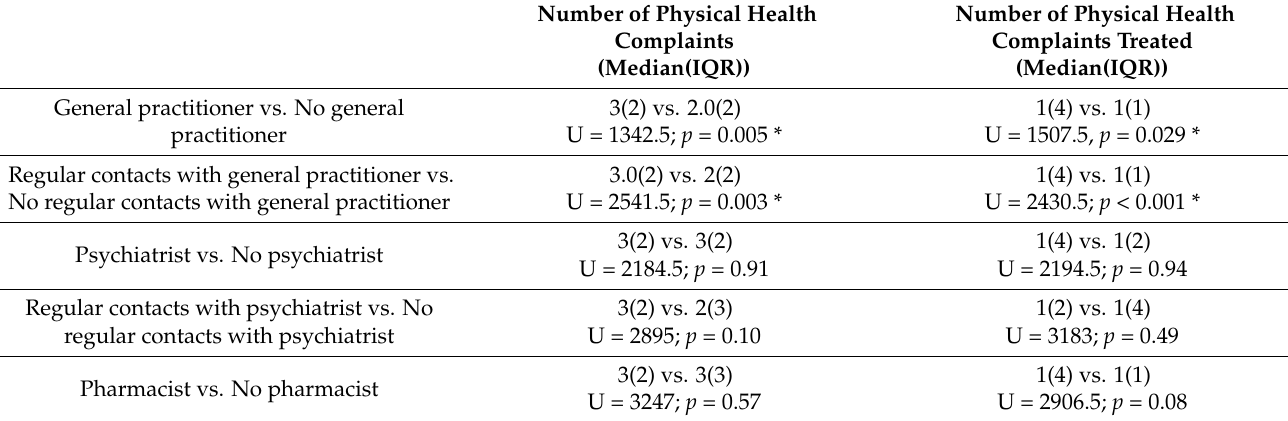
Table 4. Differences in number of physical health complaints/number of health complaints treated, compared between having a particular health care professional or not, and having regular (at least monthly) contacts with a particular health care professional or not (Median values +